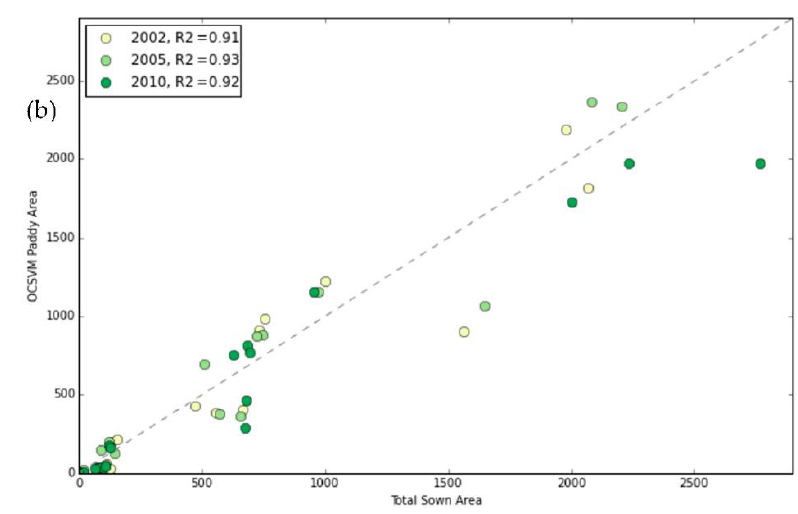
Figure 6. R 2 for OCSVM 2010 , OCSVM 2005 and OCSVM 2002 compared to Sown Area of rice for the season with the largest extent ( a ) and Total Sown Area for provinces with one dominant rice crop per year ( b ).